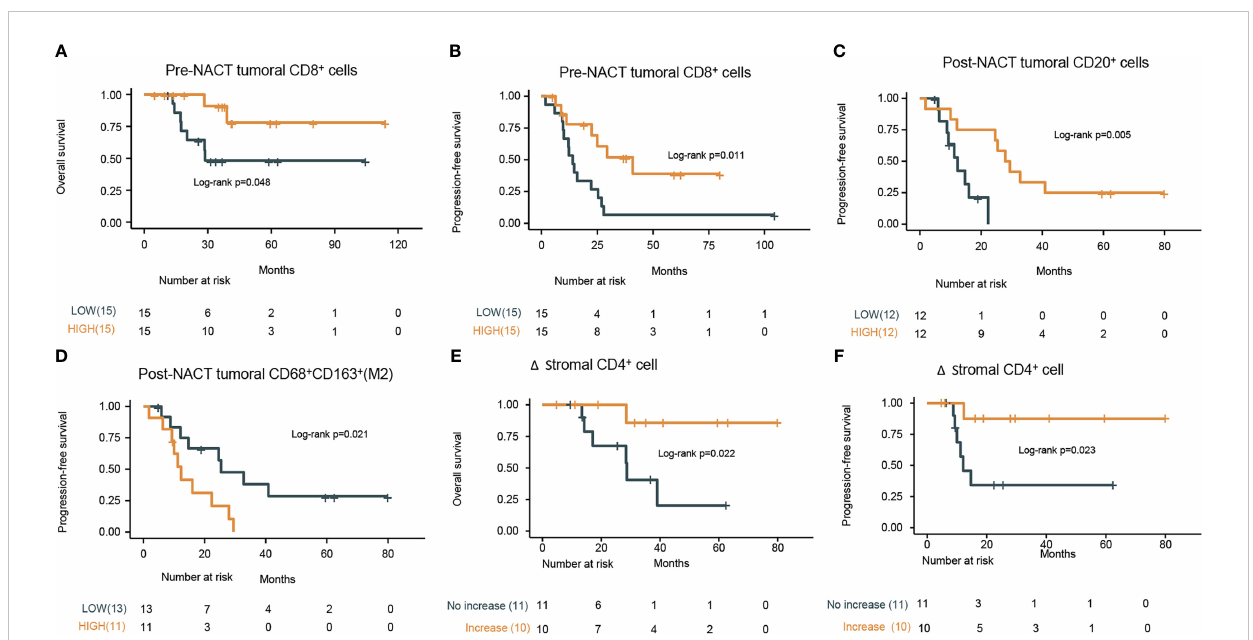
FIGURE 3 Prognostic values of pre-NACT and post-NACT immune cell density. Kaplan – Meier curves of the (A) overall survival (OS) and (B) progression-free survival (PFS) strati fi ed by in fi ltration degree of pre-NACT tumoral CD8 + cells (low or high based on the median value) in the tumor specimens. (C) Kaplan – Meier curves of PFS strati fi ed by the in fi ltration degree of tumoral CD20 + cells post-NACT (low or high based on the median value) in the tumor specimens. (D) Kaplan – Meier curves of PFS strati fi ed by the in fi ltration degree of tumoral CD68 + CD163 + (M2 macrophages) cells post-NACT (low or high based on the median value) in the tumor specimens. (E) Kaplan – Meier curves of the OS strati fi ed by the increase in the density of stromal CD4 + cells (increase or no increase) in the tumor specimens. (F) Kaplan – Meier curves of the progression-free survival (PFS) strati fi ed by the increase in the density of stromal CD4 + cells (increase or no increase) in the tumor specimens. P values refers to log rank tests between the indicated